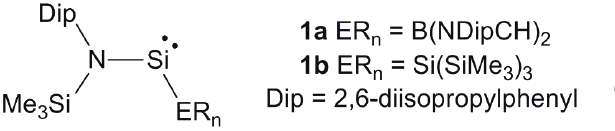
Figure 1: Examples of previously reported acyclic two-coordinate silylenes.